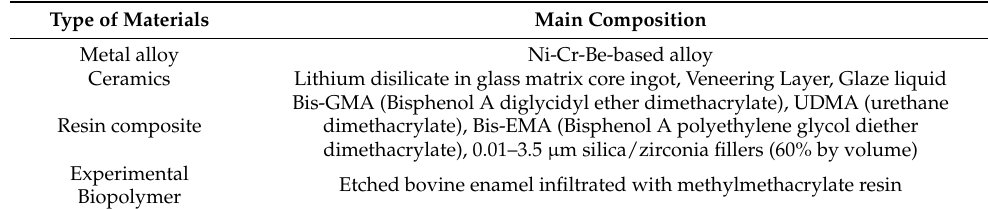
Table 1. Main composition of the tested